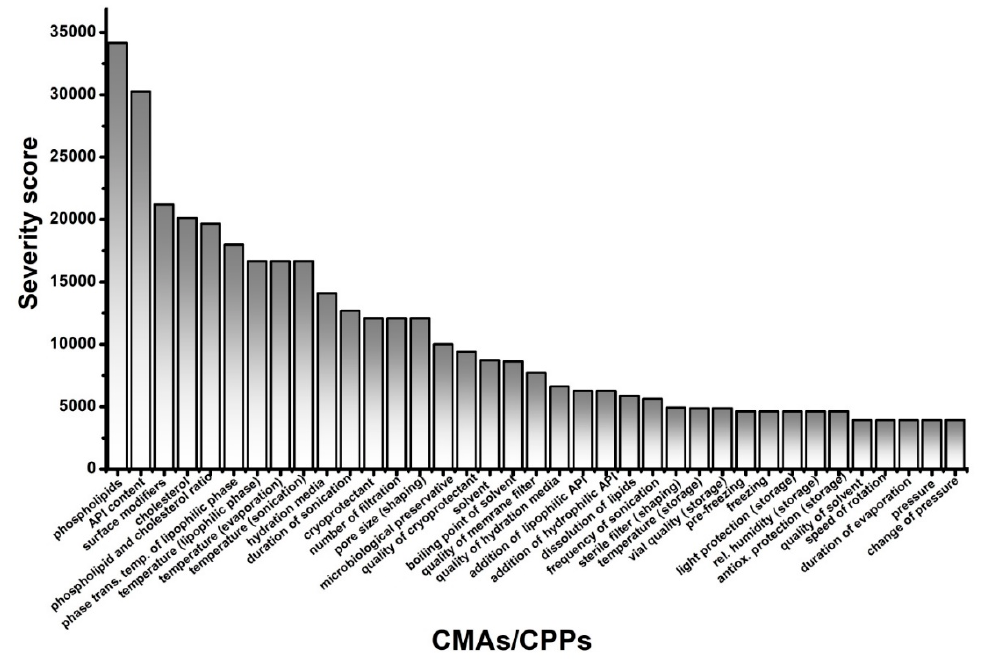
Figure 4. Rankings of the critical material attributes (CMAs) of the liposome components along with the critical process parameters (CPPs) of thin-film hydration.